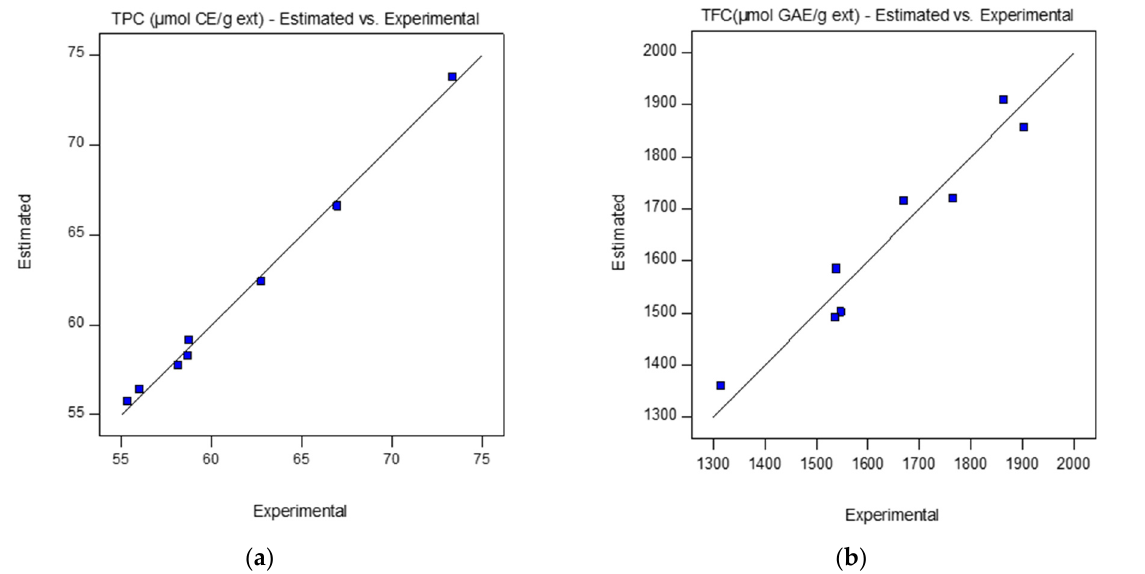
Figure 2. Estimated (represented by the straight line), and experimental values for the rice bran oil recovered by scCO 2 extraction at the FFD design tests conditions shown in Table 1: ( a ) TPC ( μ mol CE/g ext) and ( b ) TFC ( μ mol GAE/g ext).